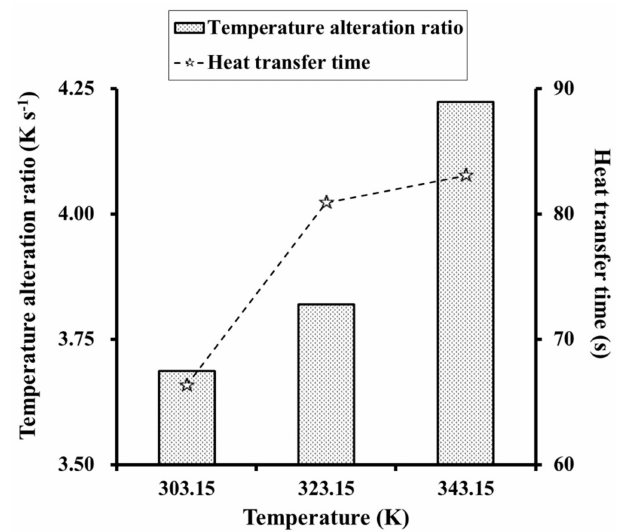
Figure 17. Influence of applied temperature on TAR and heat transfer